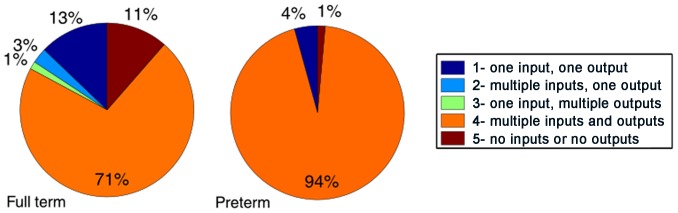
Connectedness of nodes in the full-term (left) and preterm (right) infant-mother interaction networks.A coarse-grained degree distribution analysis has been performed on the data, separating the combined mother-infant behavioral states into the 5 categories listed to the right. The 5 categories separate the states into the very sparsely connected states which have either one input and one output (1) or either no input or no output (5), states which have multiple inputs but only one output (2), states which have only one input but multiple outputs (3) and finally those which have multiple inputs and outputs (4).